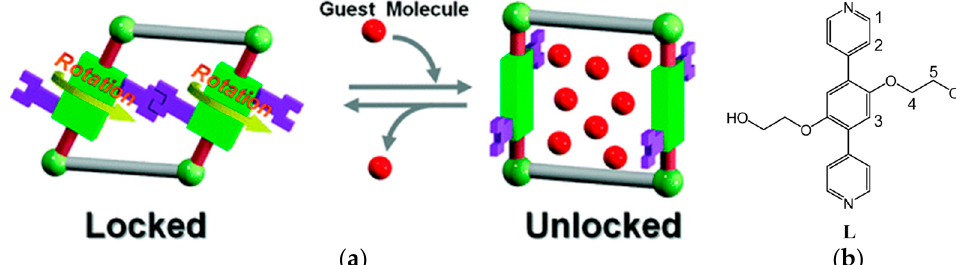
Figure 22. ( a ) Illustration of gate-opening effect in 2-D sheet framework with glycol functionalization; ( b ) Schematic structure of linker. Reproduced with permission from [84]. Copyright American Chemical Society, 2009.